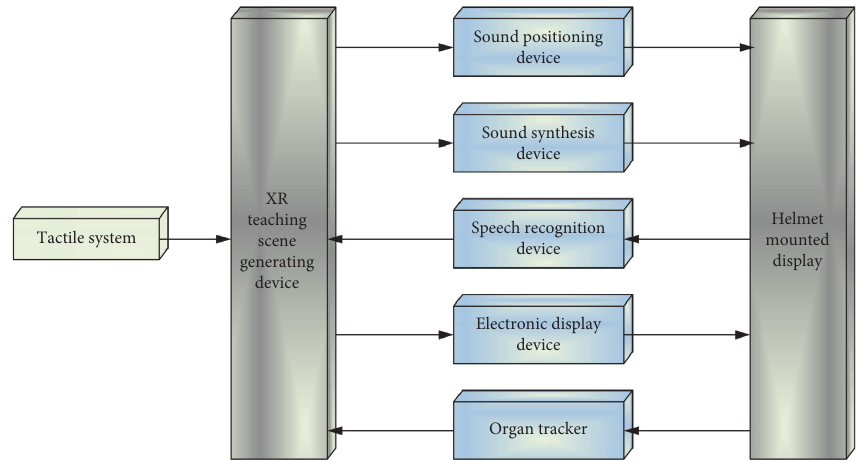
Figure 4: Schematic diagram of basic working process of immersive XR teaching